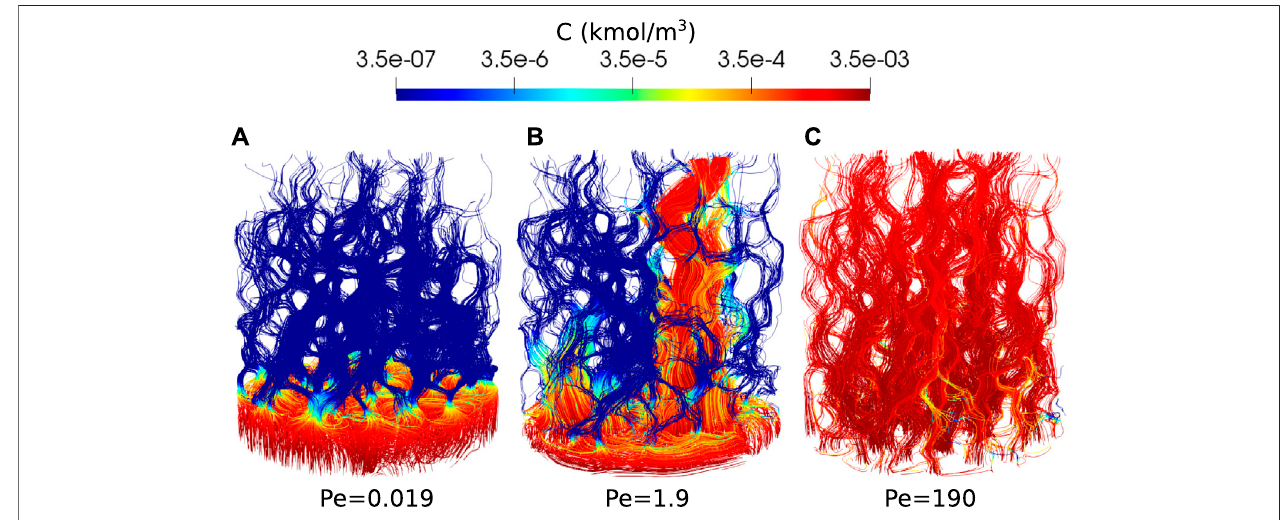
FIGURE 11 | Reactant concentration along streamlines during Ketton dissolution in three different regimes, [ (A) : Pe=0.019, (B) : Pe=1.9 and (C) : Pe=190] shown when the porosity has reached approximatively 0.28.